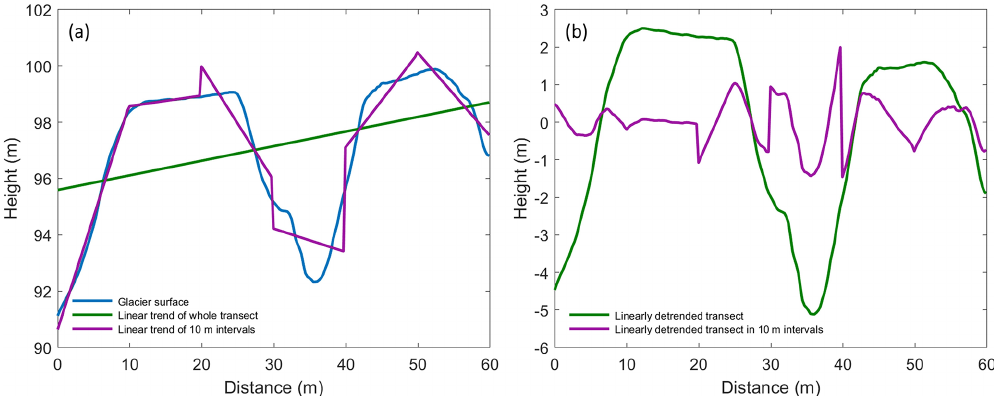
Figure 3. Graph (a) shows a random transect of two roughness elements on Fridtjovbreen (blue line). The transect is linearly detrended either over the whole profile (green) or in 10m intervals (purple). Graph (b) illustrates the linearly detrended surface data applied at the whole transect (green line) or applied at 10m intervals (purple